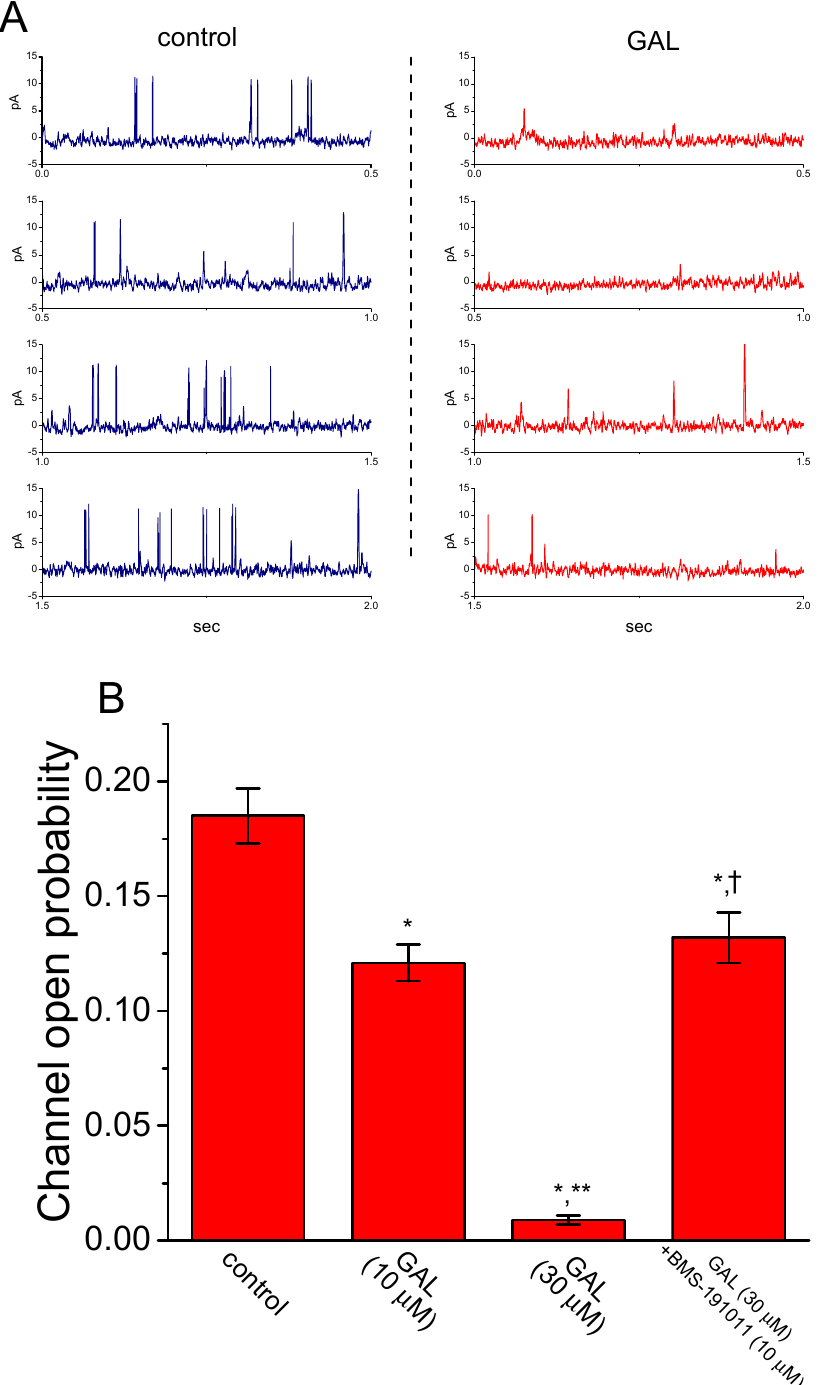
Figure 10. E ff ect of GAL-021 on BK Ca -channel activity in α - hSlo -expressing HEK293T cells. Cells were suspended in high-K + solution containing 0.1 µ M Ca 2 + , and inside-out current recordings were made at the holding potential of + 60 mV. ( A ) Representative BK Ca -channel currents obtained in the control (left) and after bath application of 30 µ M GAL-021 (right). ( B ) Summary bar graph depicting e ff ect of GAL-021 (10 or 30 µ M) and GAL-021 (30 µ M) plus BMS-191011 (10 µ M) on the open-state probability of BK Ca (or KCNMA1) channels (mean ± SEM and n = 6 to 8 for each bar). * , Significantly di ff erent from control or GAL-021 (10 µ M) alone group ( p < 0.05); ** , significantly di ff erent from control ( p < 0.01); and † , significantly di ff erent from GAL-021 (30 µ M) alone group ( p <